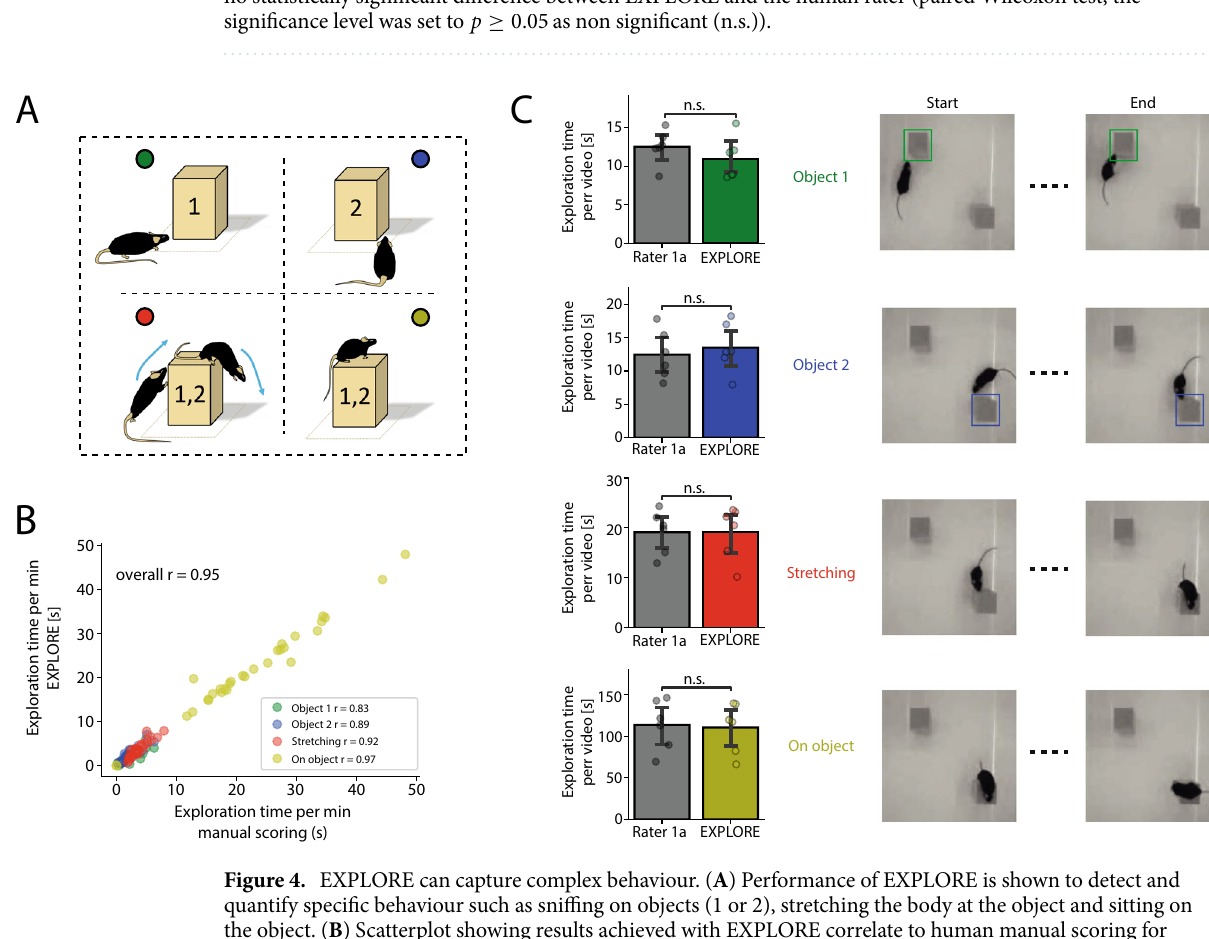
Figure 4. EXPLORE can capture complex behaviour. ( A ) Performance of EXPLORE is shown to detect and quantify specific behaviour such as sniffing on objects (1 or 2), stretching the body at the object and sitting on the object. ( B ) Scatterplot showing results achieved with EXPLORE correlate to human manual scoring for each type of behaviour. ( C ) No significant difference was found between EXPLORE and manual scoring after comparing the time quantified for each specific behaviour (paired Wilcoxon test, the significance level was set to p ≥ 0.05 as non significant